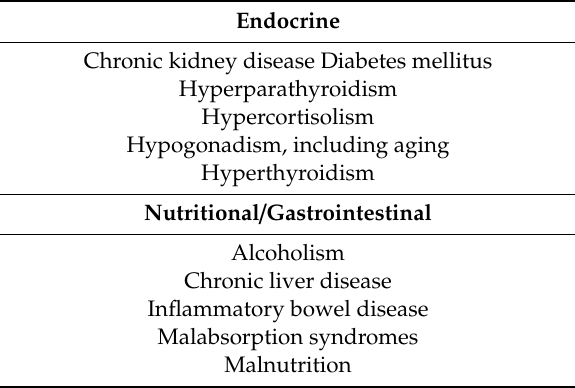
Table 1. Causes of osteoporosis in men, excluding